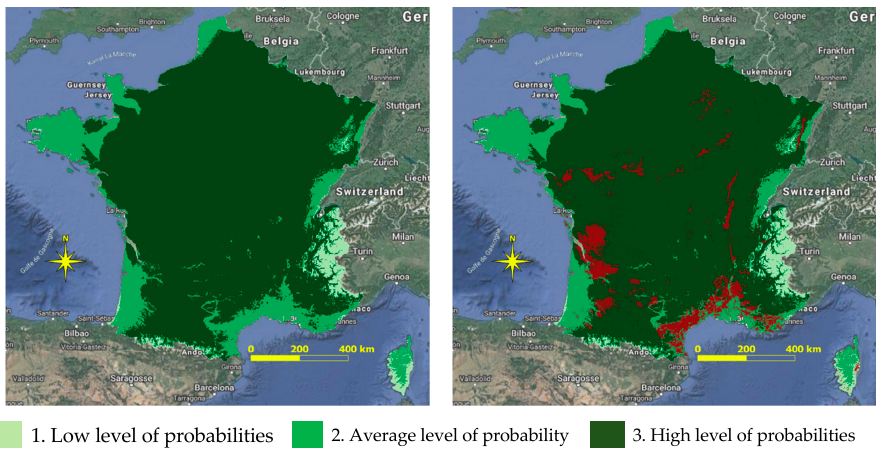
Figure 9. Potential suitable areas for grapevine crop according to RCP 6.0 climate scenario for 2070. Grapevine crops declared in 2018 are represented in red.